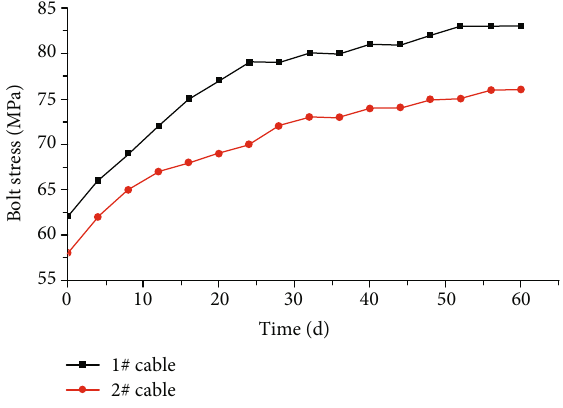
Figure 16: Deformation value of the roadway surrounding rock.